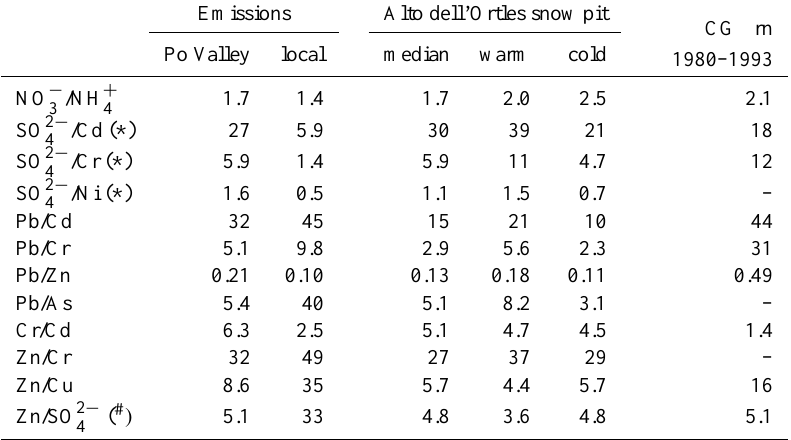
Table 4. Trace species ratios for estimated local and Po Valley emissions (2000AD), Alto dell’Ortles snow and Colle Gnifetti firn (1980 to